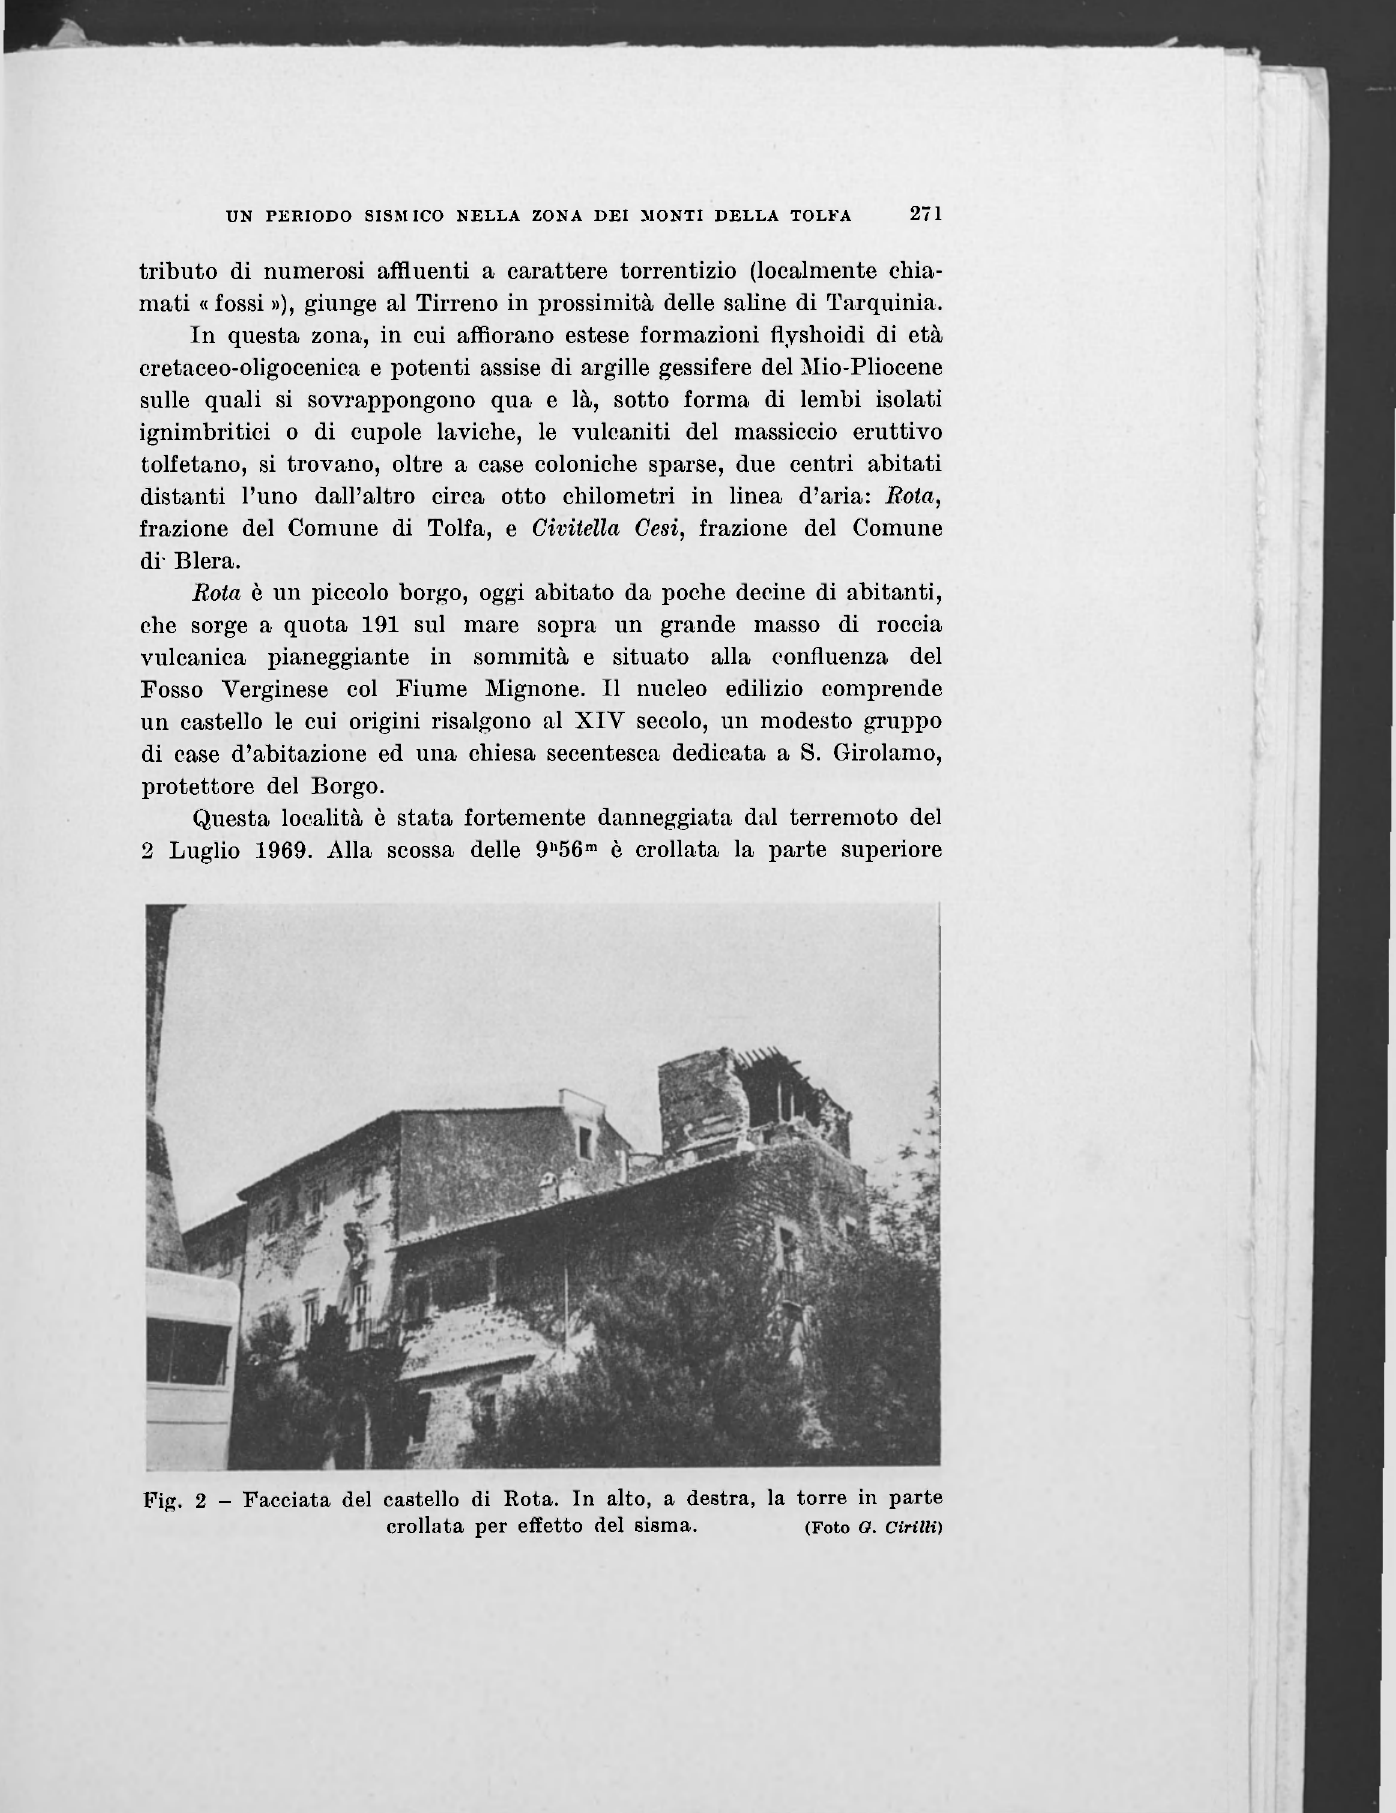
Fig. 2 - Facciata del castello di Rota. In alto, a destra, la torre in parte crollata per effetto del